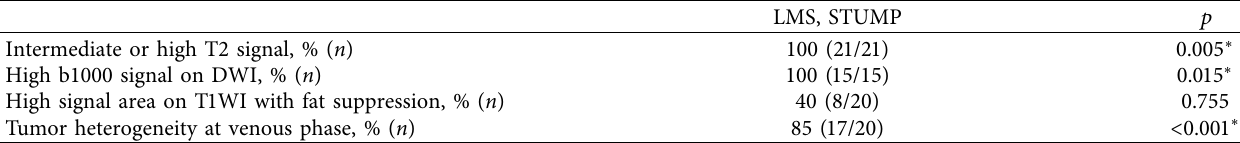
Table 3: Univariate analysis of MRI-specific features for type 2 uterine sarcomas.